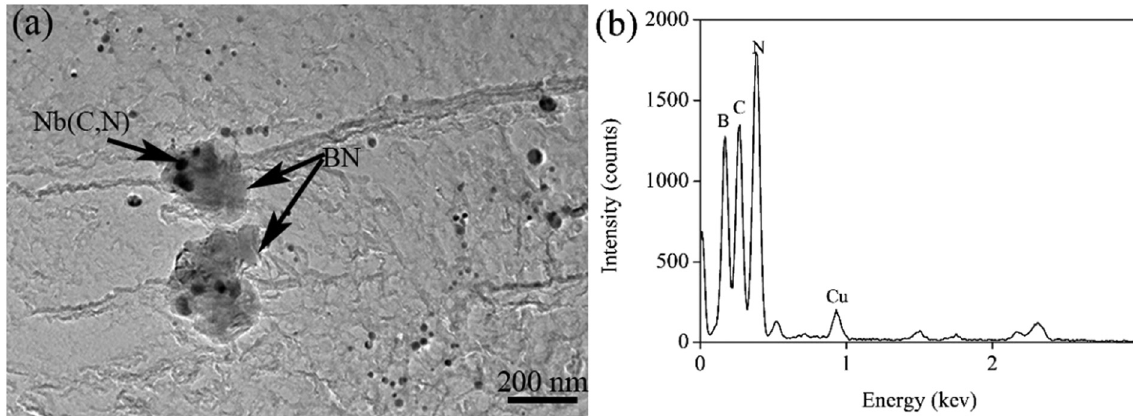
Figure 11: BN precipitates morphology ( a ) and EDS analysis result ( b ) of steel 4#.